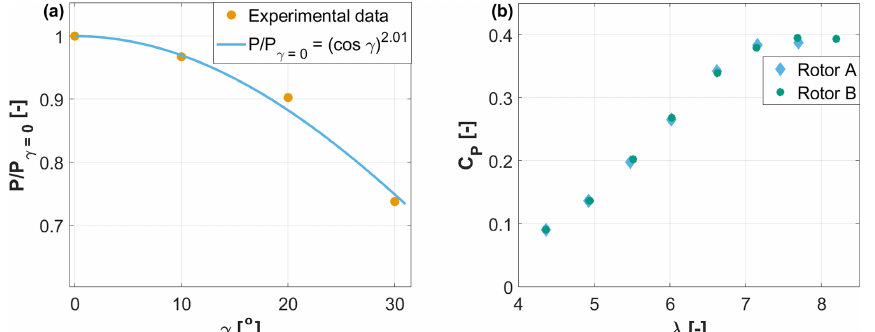
Figure 10. Power output as a function of the wind misalignment angle γ , normalized with respect to the γ = 0 ◦ case, for the UTD-LT inflow case (a) . C P vs. λ for two G06 rotors in the same inflow conditions (TUM-HT) and same pitch angle β = 0 ◦ (b) .